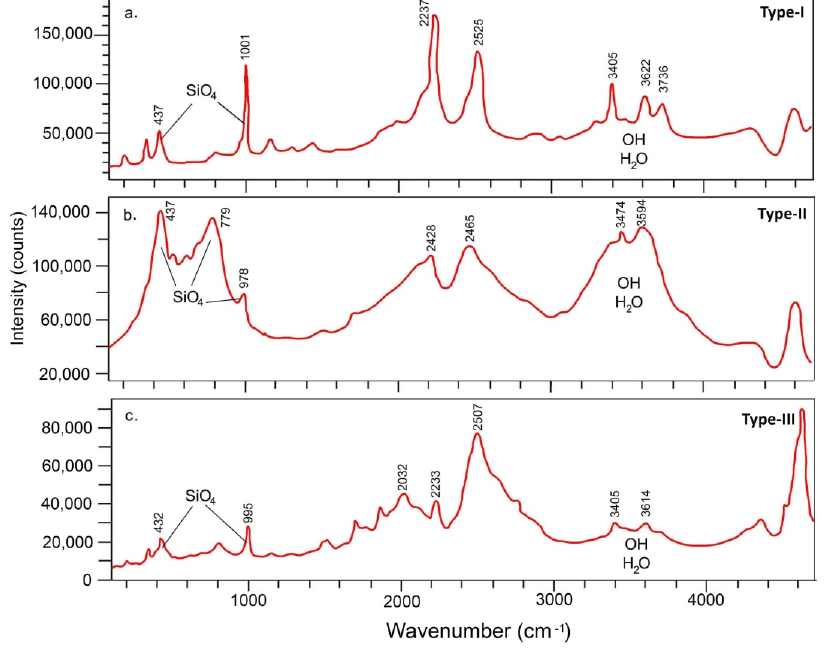
Figure 8. Result of laser Raman spectroscopy for different zircon types.